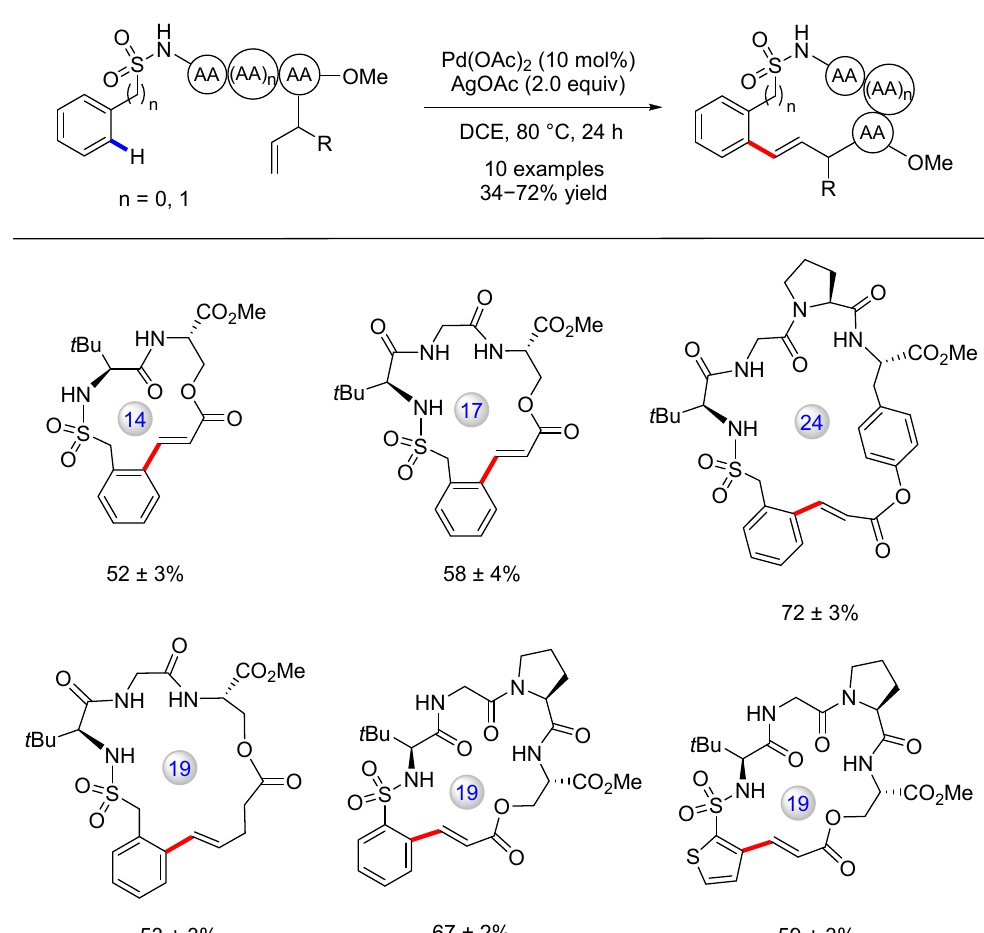
Figure 15. Macrocyclization of peptidosulfonamides via palladium(II)-catalyzed intramolecular C(sp 2 )–H bond olefination [74].